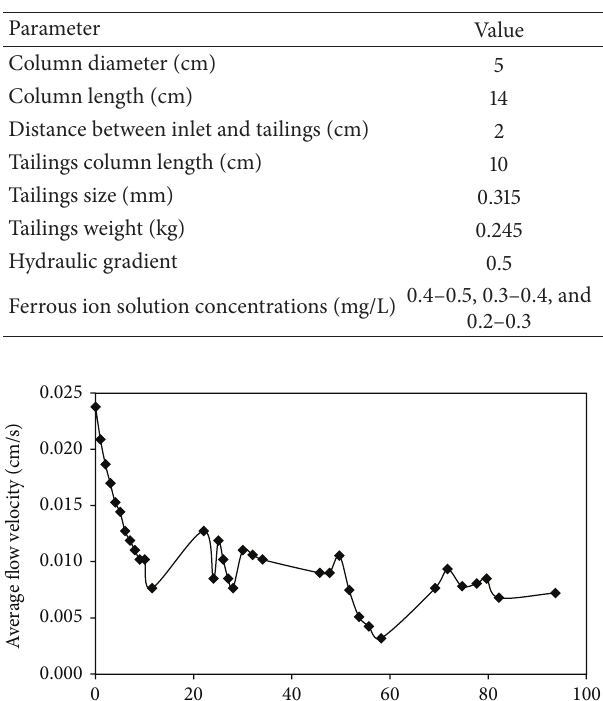
Table 4: Characteristics of the chemical column experiments.